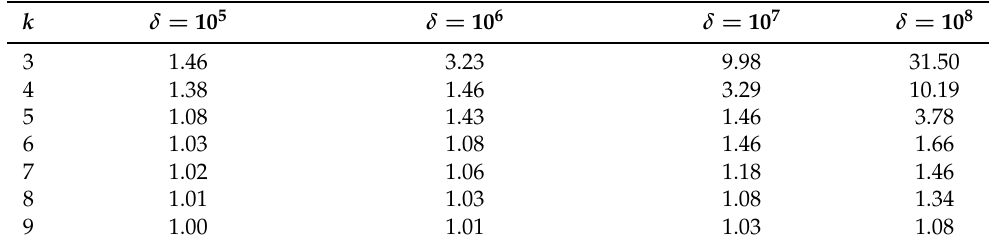
Table 4. Computed estimates of κ { 10 5 ,10 6 ,10 7 ,10 8 } .